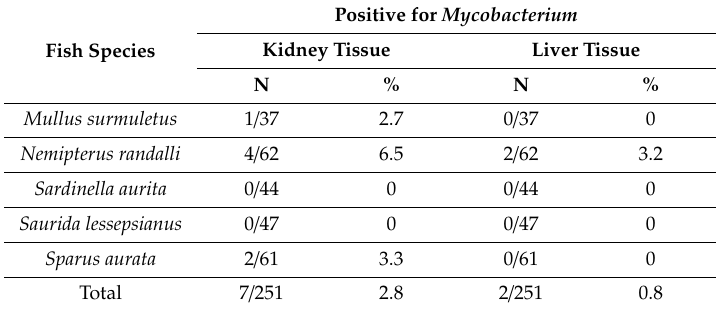
Table 9. Relative distribution and percentage of Mycobacterium sp. in kidney and liver tissues from wild and cultured fish. Only specimens tested for both tissues were included in the statistical analysis.